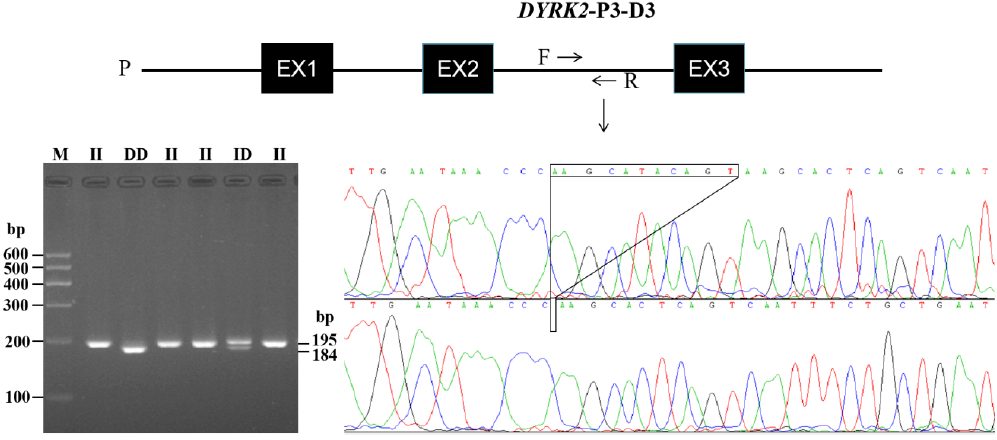
Figure 1. The electrophoresis diagrams and sequence diagrams of InDel locus of bovine DYRK2 gene. Note that P represents promoter region and EX represents exon. Table 2. Frequencies of genotypes and alleles and diversity parameter for InDel of DYRK2 gene in cattle. Populations Sizes Genotypic Allelic HWE Population frequencies frequencies P values parameters II ID DD I D Ho He Ne PIC XJBC 388 0.493 0.393 0.113 WLC 50 1.000 1.000 1.000 1.000